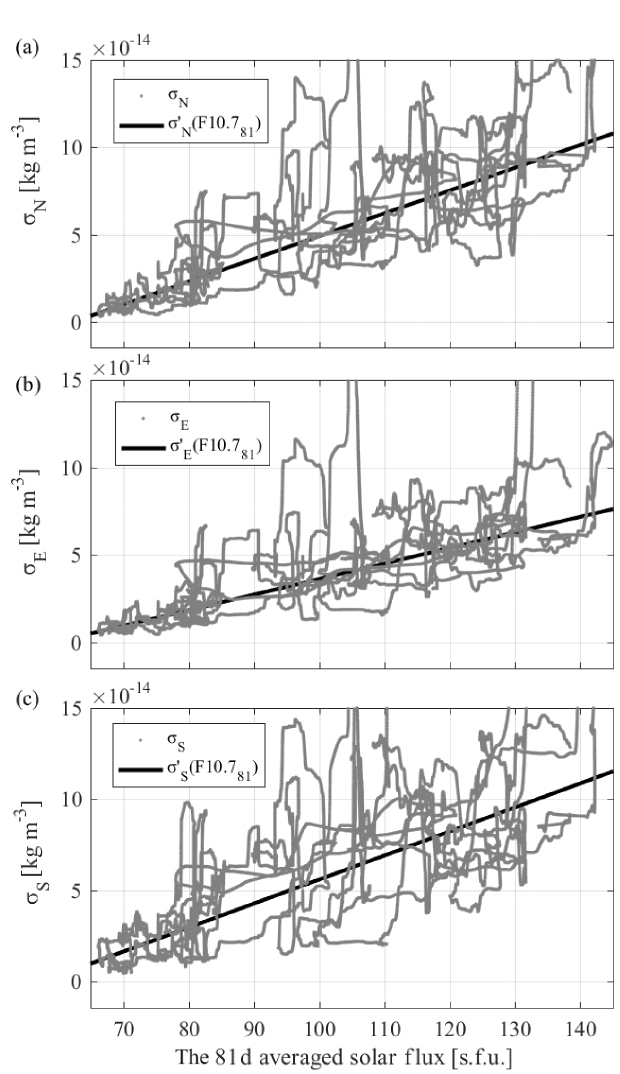
Figure 3. Linear fit of 30d standard deviation sliding window of residual density disturbances at an altitude of 475km from Fig. 2 at (a) NPR and (b) SPR with respect to the 81d averaged F10.7 solar flux index. Note that the seasonal variation (Table 3) has not been removed from (c) .